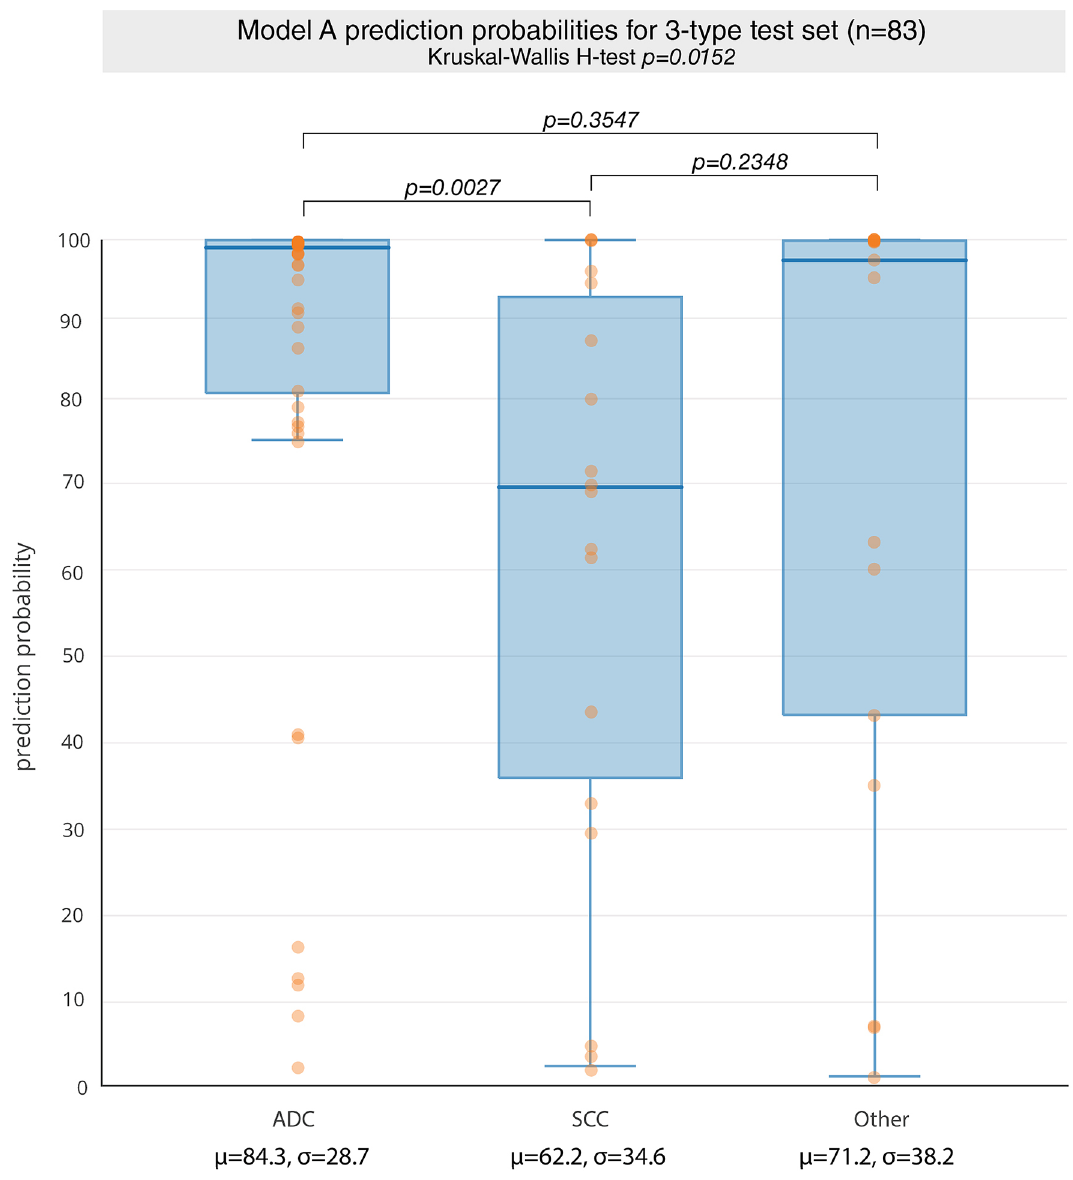
Figure 5. Model A as probabilistic classifier of non-small cell histology in 83 sample held-out test set containing all histology types. There is a statistically significant difference in predictions comparing all 3 histology groups: ADC, SCC, Other. Comparison of ADC vs SCC revealed a statistically significant difference with p-value of 0.003, while comparison of SCC vs Other had a p-value of p = 0.235, and ADC vs Other had a p-value of